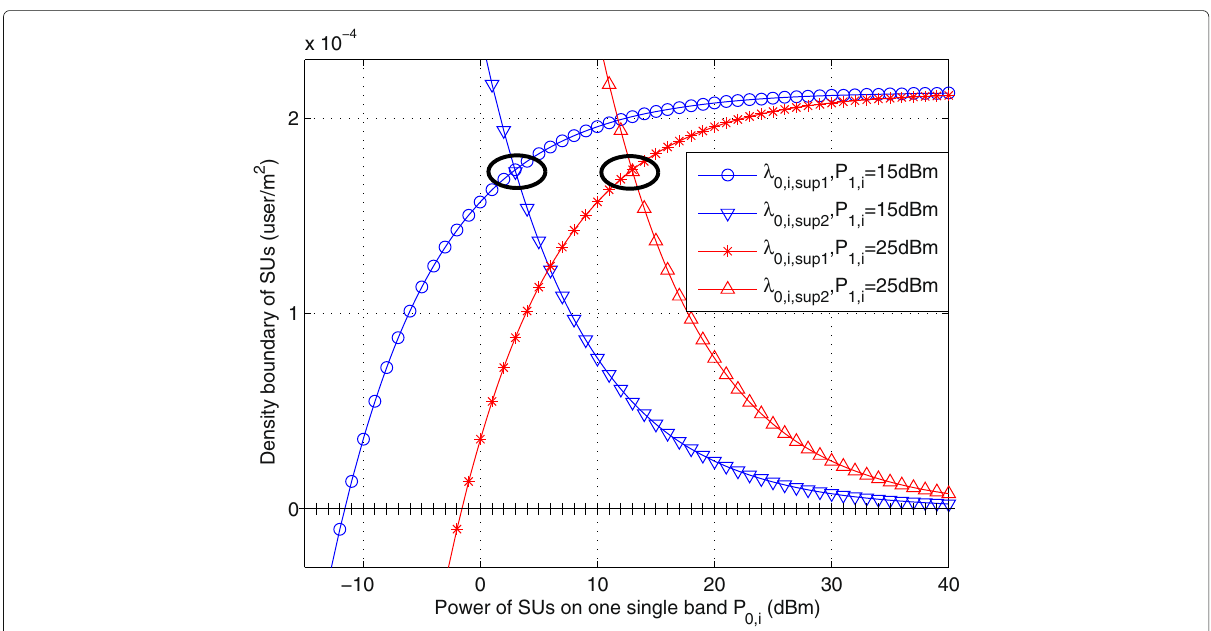
Fig. 4 Density boundary of SUs vs. power of SUs on one single band